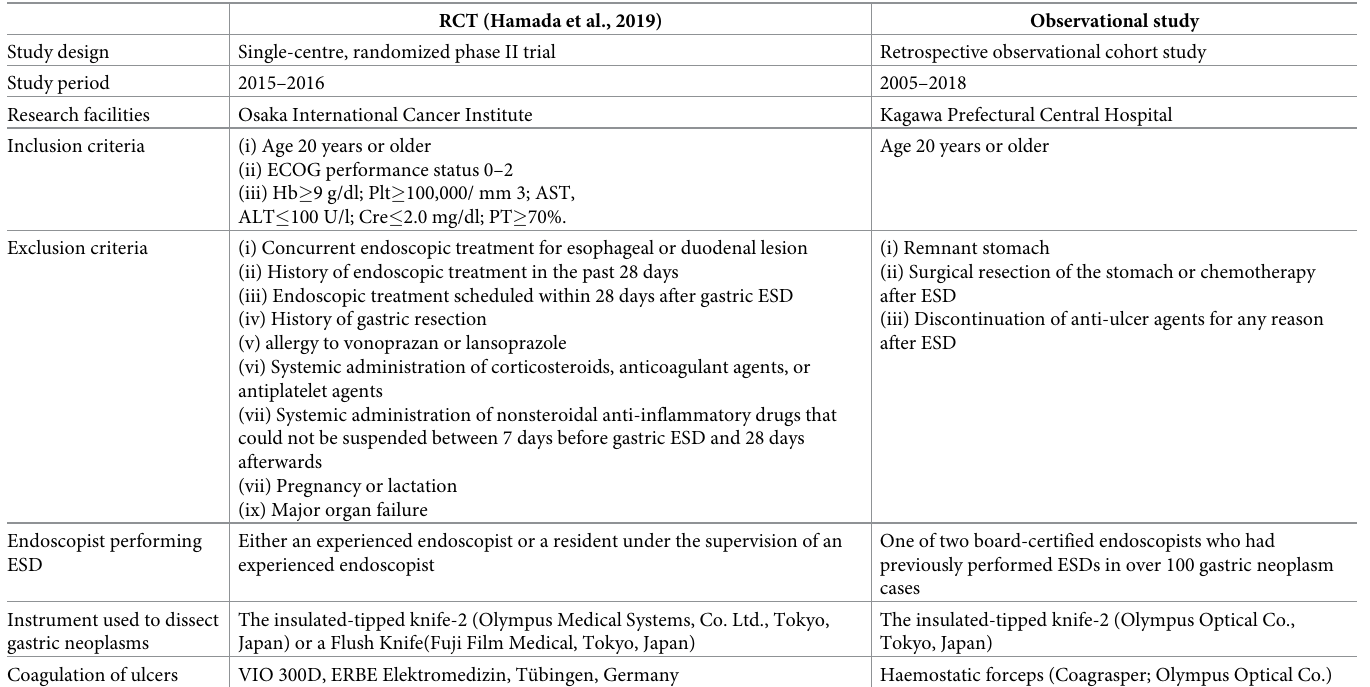
Table 1. Summary of pooled